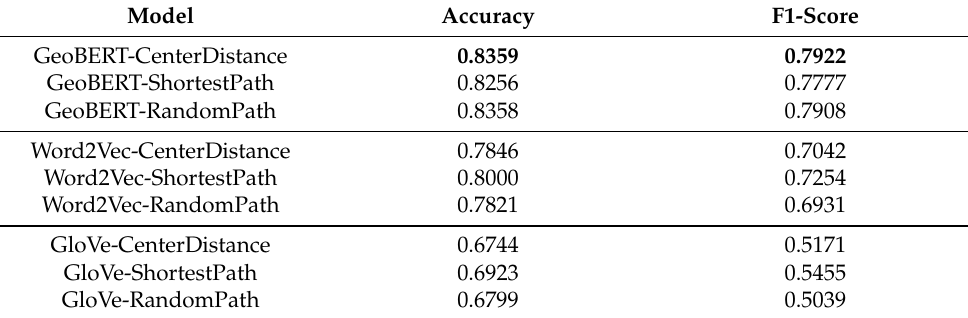
Table 13. Evaluation on store site recommendation (POIs only).